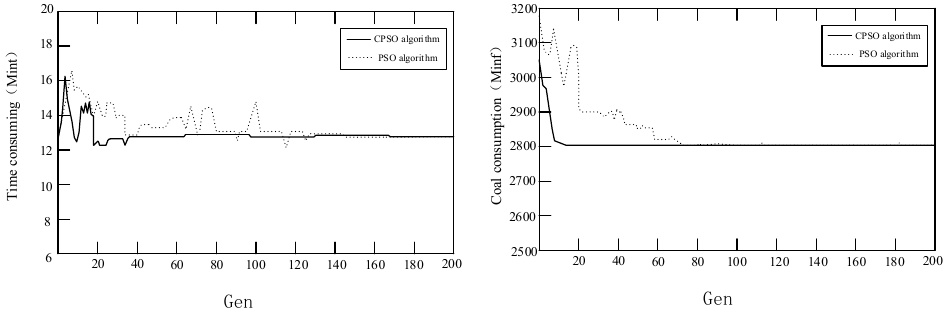
Figure 7. Comparison chart of PSO algorithm and CPSO algorithm.